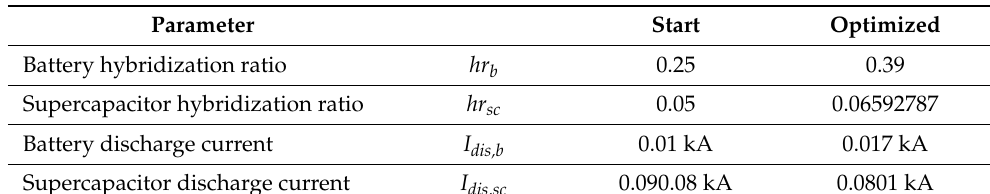
Table 3. Optimized parameters.